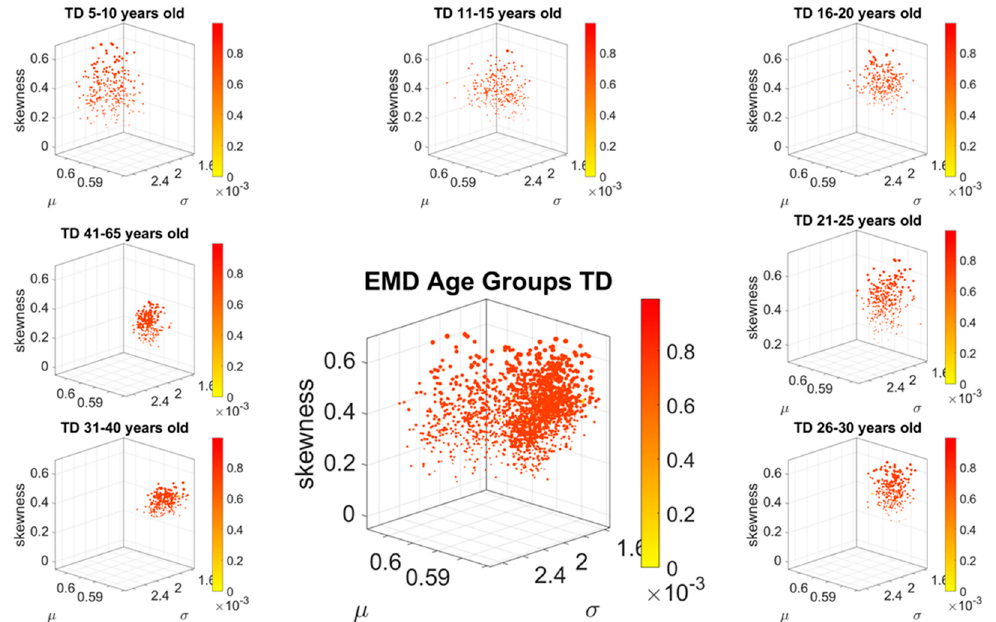
Figure 5. Smooth stochastic shifts of Gamma moment parameters characterize typical aging, with broader spread in the scatter for younger years tending to decrease the spread with aging. Pairwise ranges of EMD values are high, denoting unambiguous maximal separation from each member of the age group to every other member. The normalized color map uses the full range of neurotypical controls and ASD values across all age groups in both cohorts.